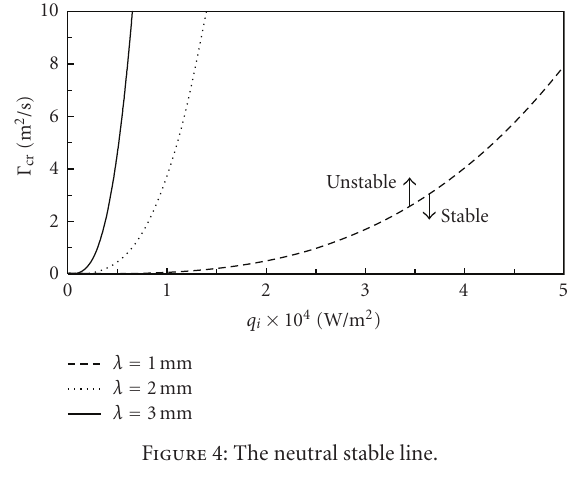
Figure 4: The neutral stable line.